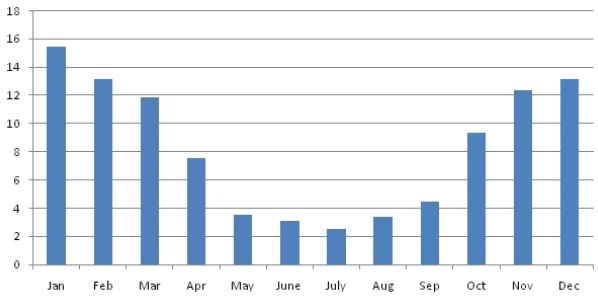
Fig. 3. Percentages of the total rainfall on a monthly basis for 2008 and